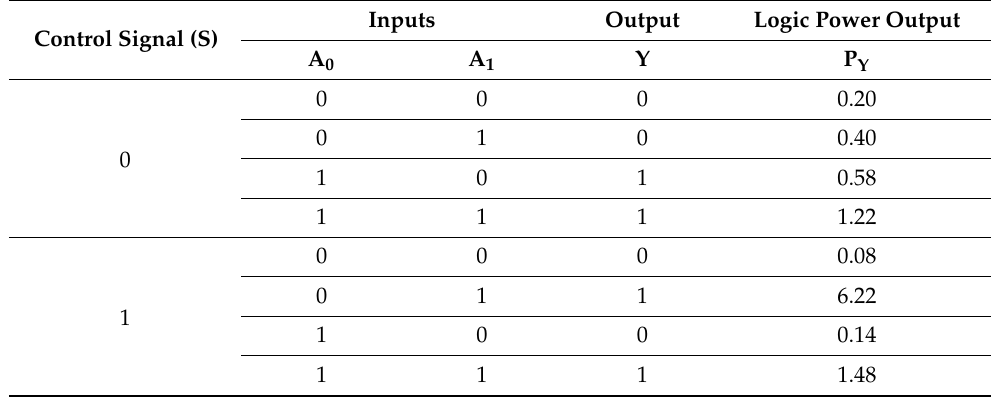
Table 4. Truth table of Multiplexer in terms of logic power output values with input power at low intensity of 0.7 × 10 9 W/m and high intensity of 3 × 10 9 W/m. Inputs Output Logic Power Output Control Signal (S) A 0 A 1 Y P Y 0 0 0 0.20 0 1 0 0.40 0 1 0 1 0.58 1 1 1 1.22 0 1